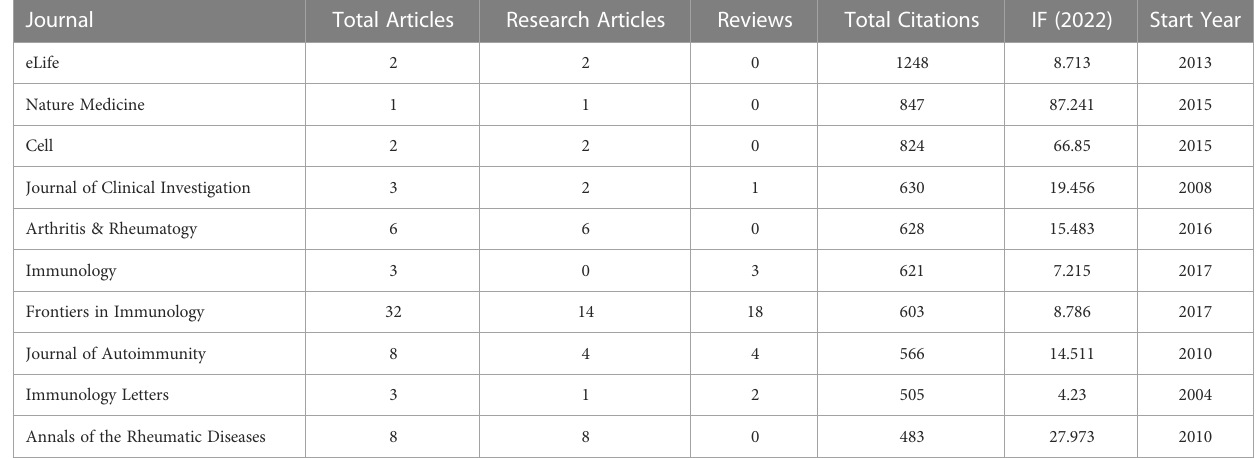
TABLE 4 The top 10 journals with the most